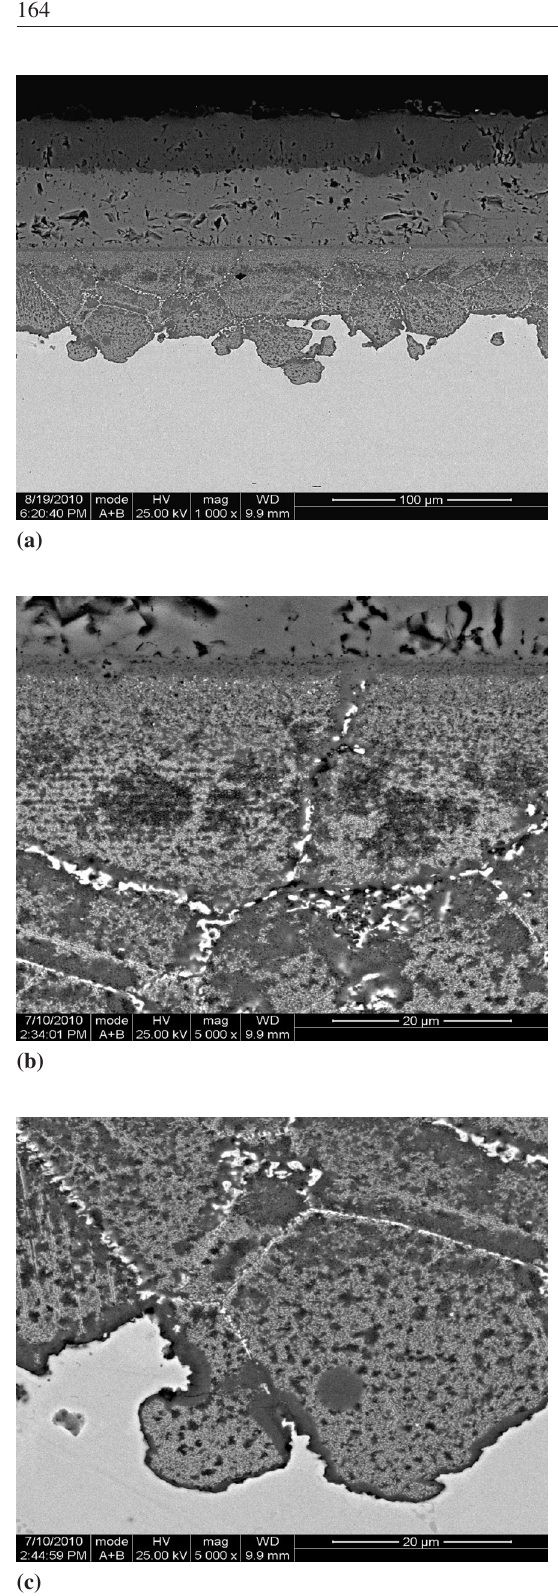
Figure 4. Cross-sectional morphologies of 304 SS corroded at 973 K in (Li,Na,K) 2 CO 3 for 500 h. (a) gerneral view; (b) and (c) the amplified views of the inner layer of